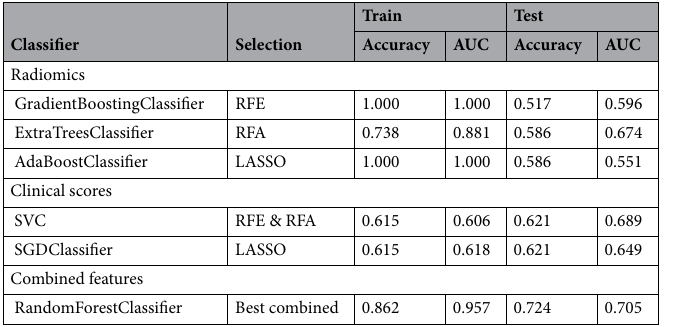
Table 3. Classifier, feature selection strategy and performance of the best lesion-wise models. AUC, area under the curve; LASSO, least absolute shrinkage and selection operator; RFA, recursive feature addition; RFE, recursive feature elimination. See Supplementary Data S8 for more